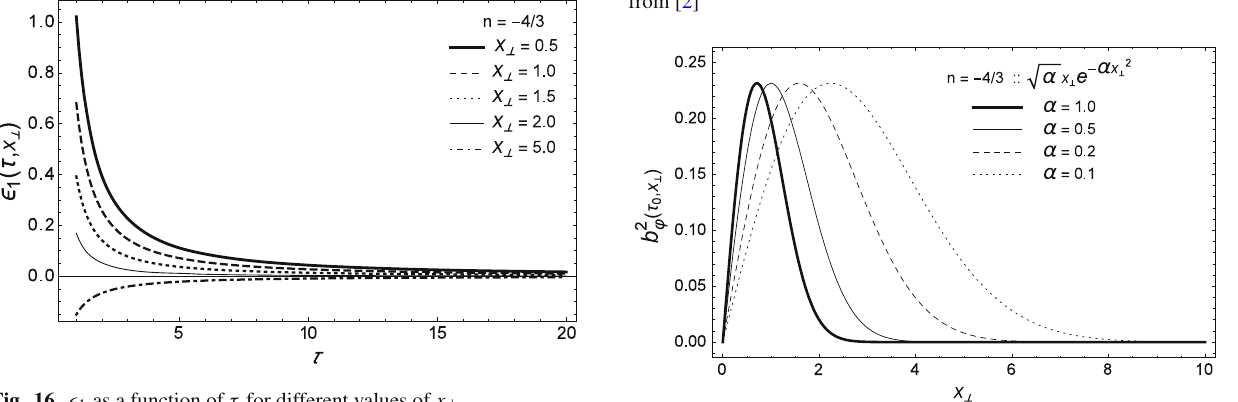
Fig. 18 Log-Log plot of (cid:5)(τ, x ⊥ ) as a function of τ for several values of x ⊥ . The bold blue line shows the dependence (cid:5)/τ 4 / 3 , where (cid:5) is in GeV/fm 3 and τ in fm. We have chosen (cid:5) = 5 . 4 GeV/fm 3 at τ = 1 fm from [2]